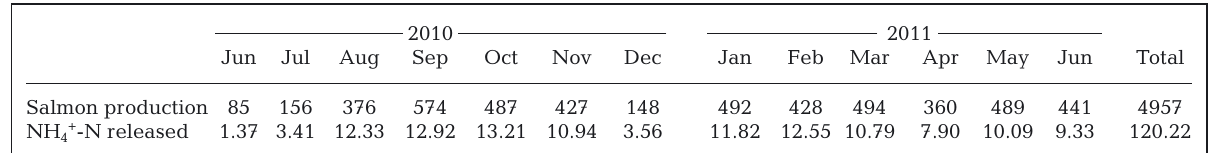
Fig. 2. Saccharina latissima . Ap- proximations of the area of fronds (A) . The area of the red rectangle is length × width = lw , while that of the inscribed red quadrilateral, a shape roughly similar to that of a frond, is lw /2. We then assume that lw /2 ≤ A ≤ lw and use the average